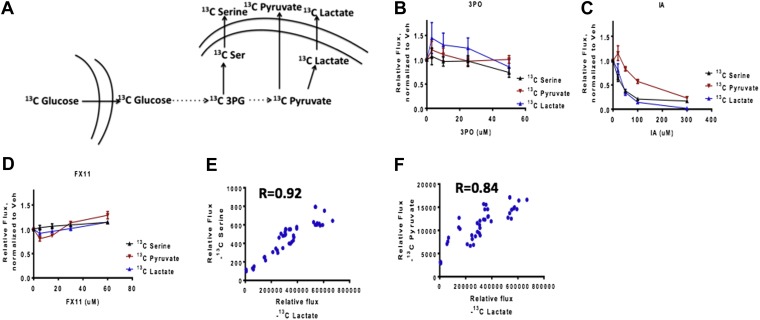
Comparison of glucose uptake rate and rate from glucose to lactate production. A) Diagram of flux experiment. Flux from glucose to pyruvate (e.g. glucose uptake), serine (biosynthetic flux), and lacate (Warburg Effect) is measured. 13C glucose is input as described in the methods. B) Comparison of fluxes for 3PO (PFK2 inhibition) treatment C) Comparison of fluxes for IA (GAPDH inhibition) treatment. D) Comparison of fluxes for FX11 (LDHA inhibition) treatment. E) Correlation between flux to serine and flux to lactate across each measurement. F) Correlation between flux to pyruvate and flux to lactate across each measurement.